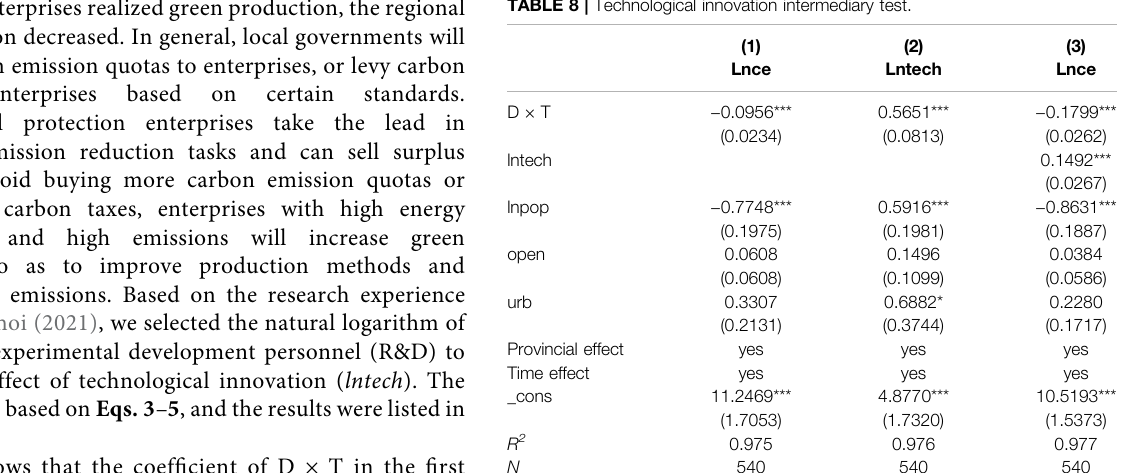
TABLE 8 | Technological innovation intermediary